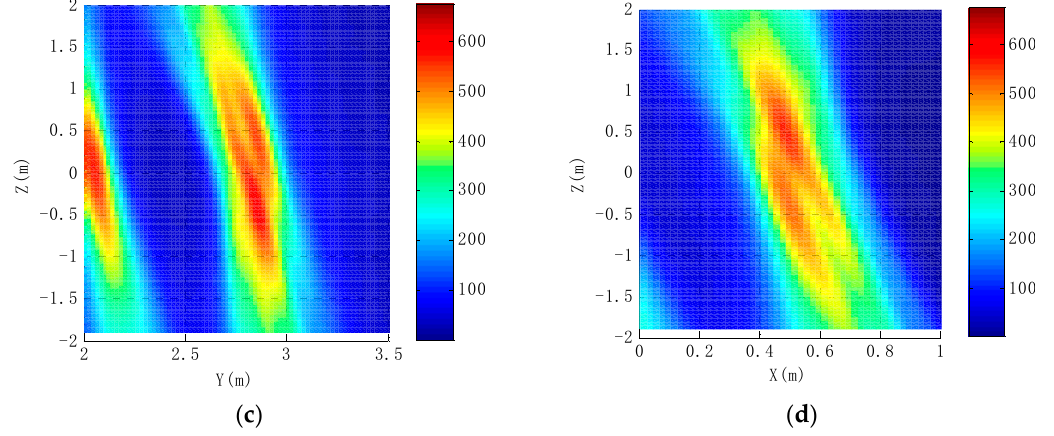
Figure 11. Distribution of scattering centers on rudder edges. ( a ) The section of the 7th and 8th scattering centers in the YZ plane; ( b ) The section of the 7th and 8th scattering centers in the XZ plane; ( c ) The section of the 9th and 10th scattering centers in the YZ plane; ( d ) The section of the 9th and 10th scattering centers in the XZ plane.